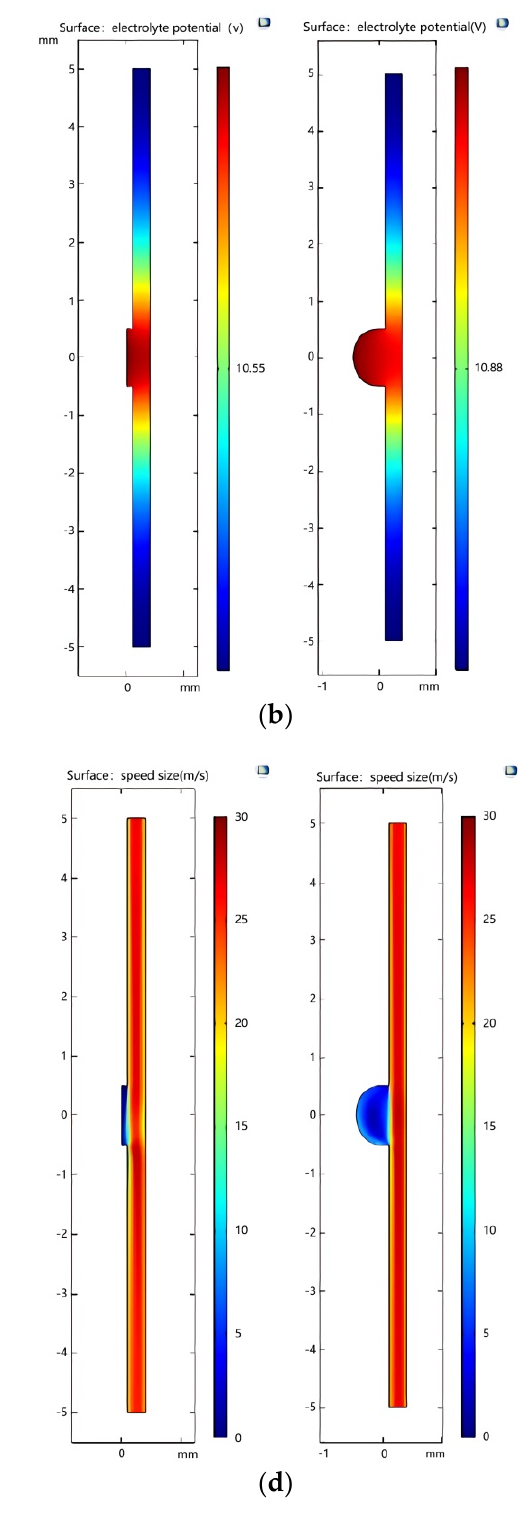
Figure 9. Simulation comparison of different processing times. ( a ) Electrolyte current density; ( b ) electrolyte potential; ( c ) electrolyte pressure change; ( d ) electrolyte flow rate change.